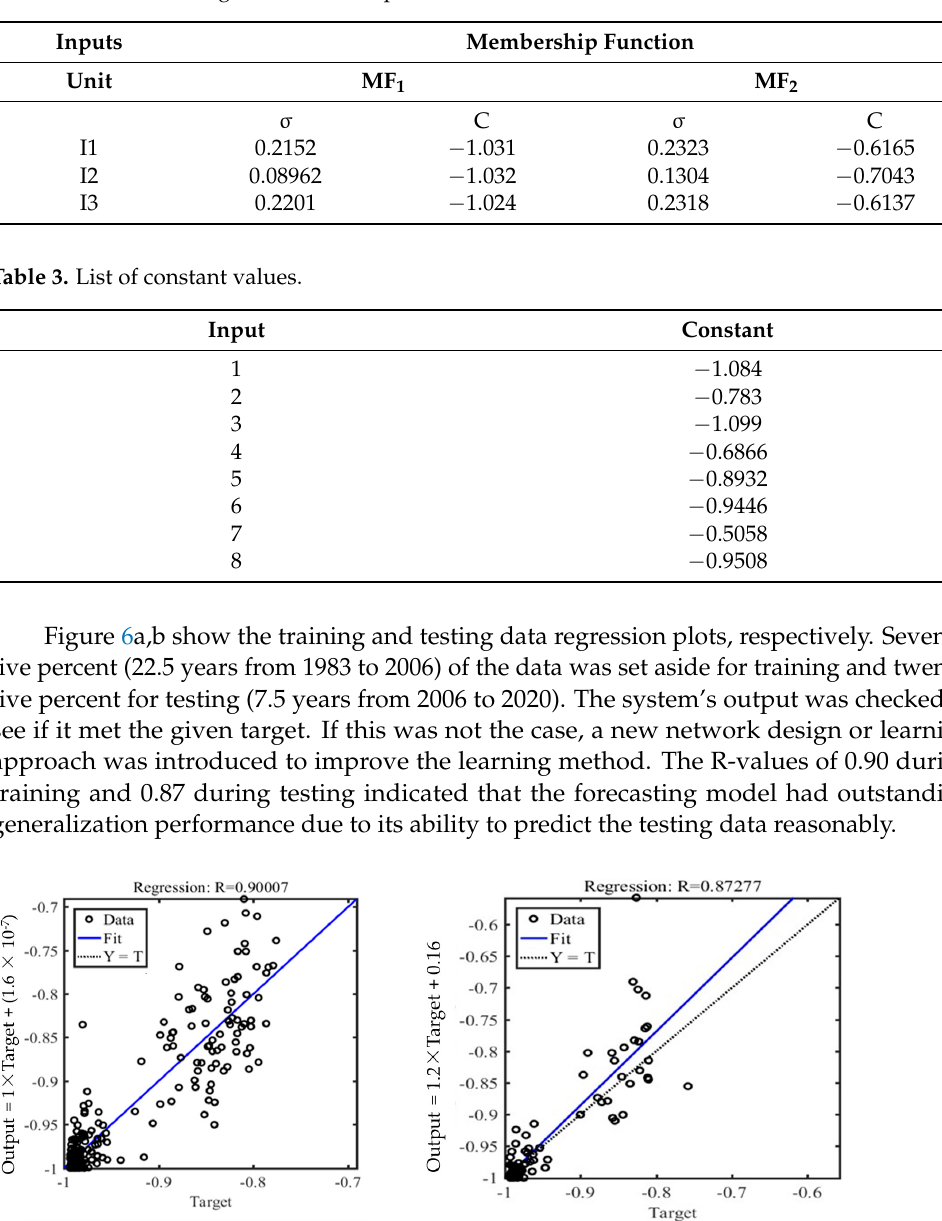
Table 2. Parameters of gbell membership functions.